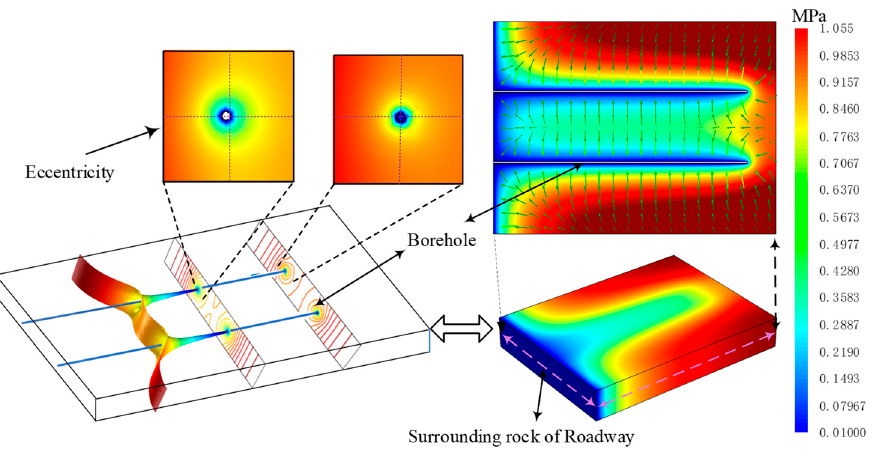
Figure 7. The pore gas cloud map of the 90 d coal seam was extracted.